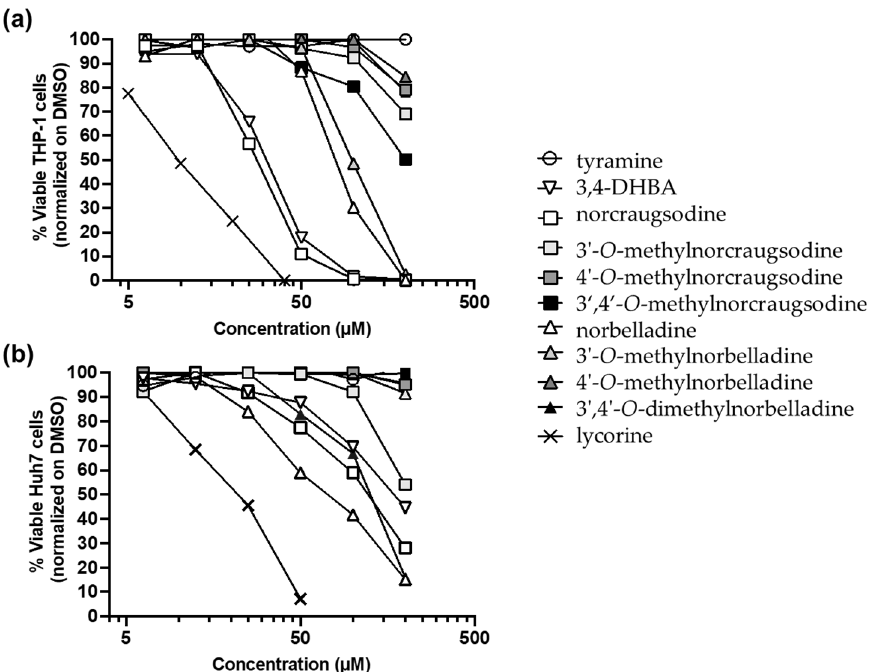
Figure 2. Cytotoxic effects of norbelladine precursors and their derivatives on Huh7 and THP-1 cells. To assess the cell viability, the cellular ATP levels were measured on ( a ) THP-1 and ( b ) Huh7 cells 72 h after alkaloid addition at concentrations of 6.25 μ M to 200 μ M. Lycorine was utilized as a positive control at concentrations of 0.3 μ M to 40 μ M. Results were normalized to equivalent concentrations of DMSO and the x -axis is displayed in log 10 . DMSO: dimethylsulfoxide; ATP: adenosine triphosphate. Table 1. EC 50 , CC 50 , and SI values of norbelladine precursors and derivatives with antiviral effects. EC 50 : median effector concentration; CC 50 : median cytotoxic concentration; SI: selectivity